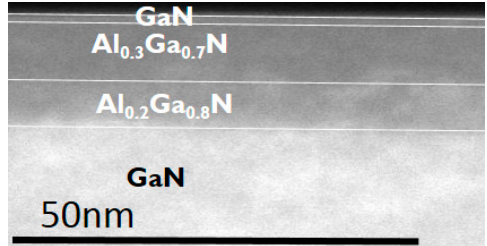
Figure 2. Transmission electron microscopy (TEM) images of the epitaxy structure with a double AlGaN barrier.